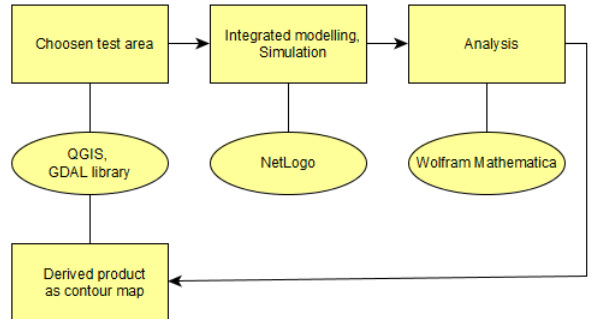
Figure 3. An overview map of the software components